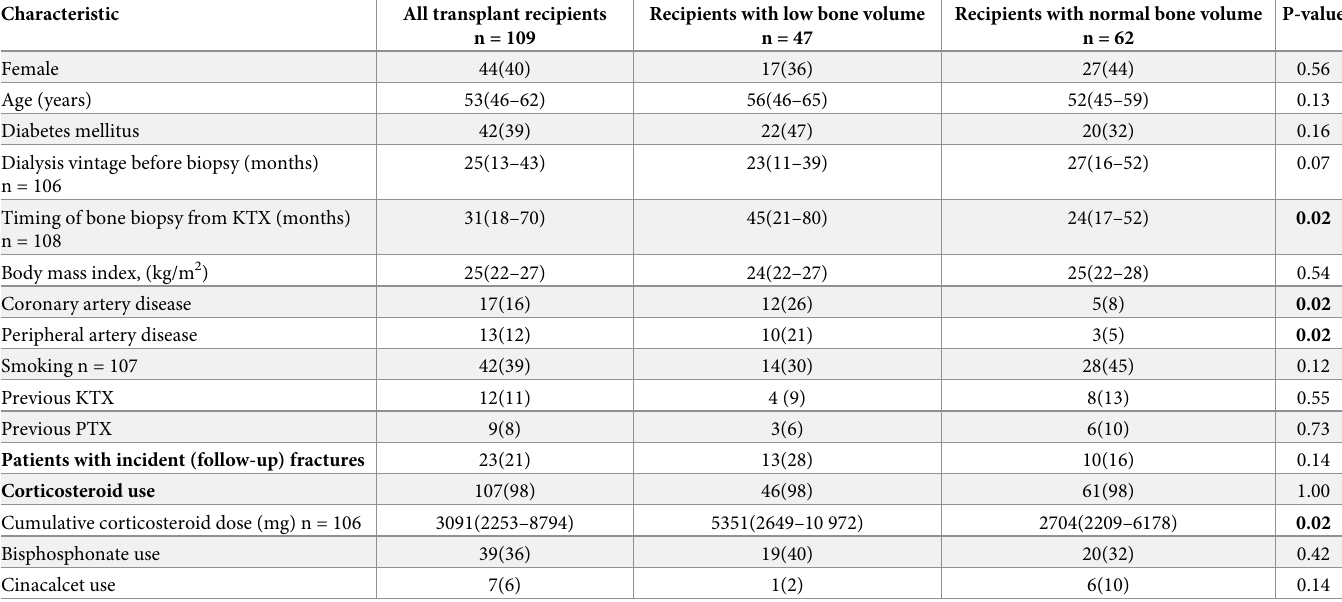
Table 1. Characteristics of the transplant patients with or without low bone volume in bone